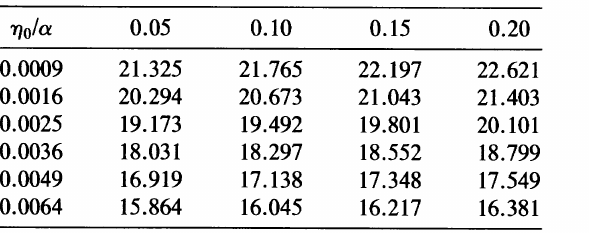
Table 7. Fundamental Frequency Coefficient fil in the Case of a Clamped-Clamped Beam of Linearly Varying Thickness TJo/a 0.05 0.10 0.15 0.20 0.0009 21.325 21.765 22.197 22.621 0.0016 20.294 20.673 21.043 21.403 0.0025 19.173 19.492 19.801 20.101 0.0036 18.031 18.297 18.552 18.799 0.0049 16.919 17.138 17.348 17.549 0.0064 15.864 16.045 16.217